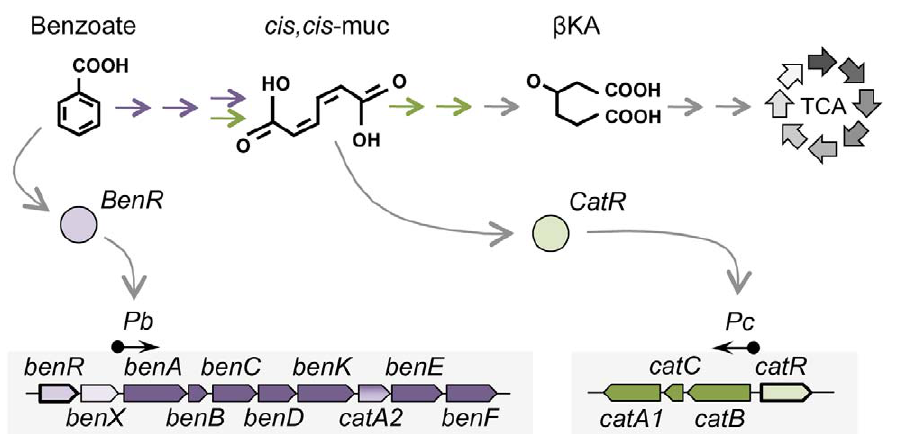
Figure 3. Catabolic pathway for benzoate degradation in P.putida . Benzoate activates the BenR regulator, which controls the expression of the ben operon. The enzymes encoded by the ben operon metabolize the conversion of benzoate to cis,cis -muconate ( cis,cis -muc), which is the signal for CatR activation. CatR controls the expression of the cat operon for the metabolization of cis,cis -muconate, which is further converted to b - ketoadipate. Finally, b -ketoadipate is converted to TCA intermediates through the action of the pca pathway (gray arrows).